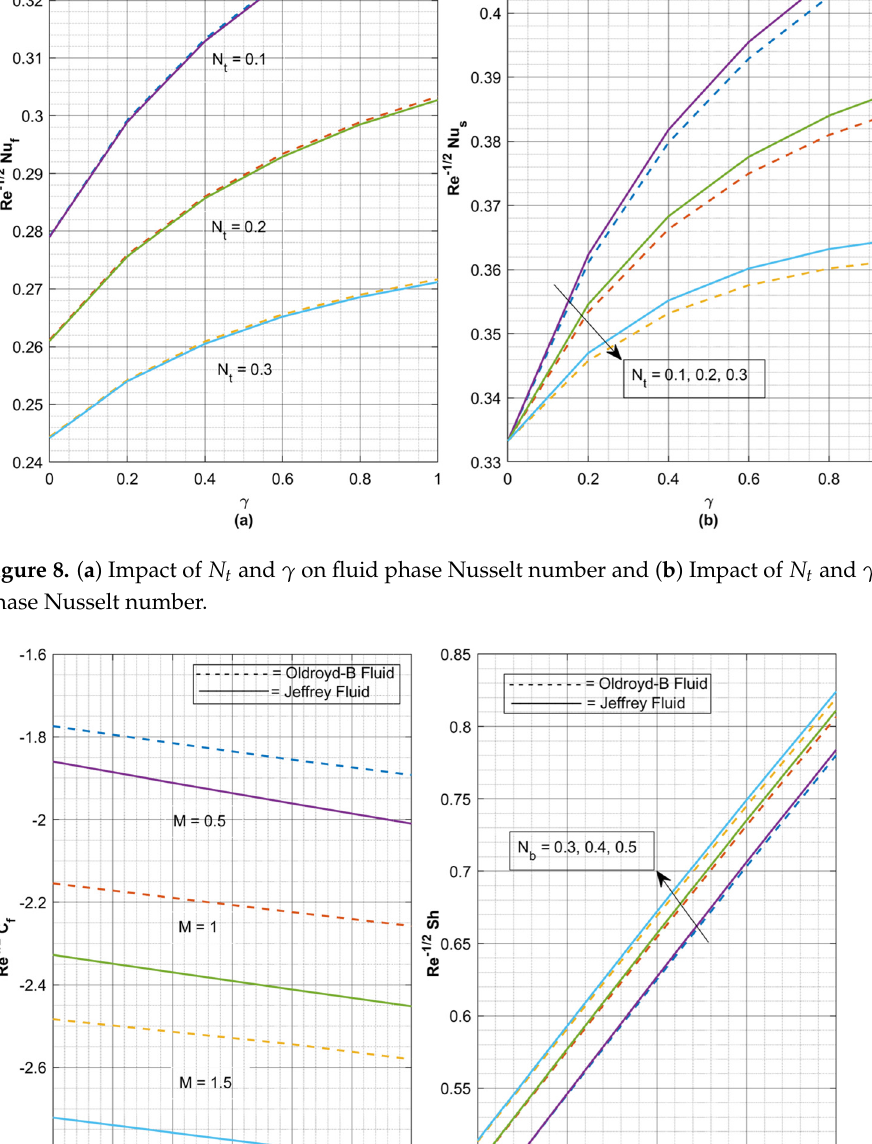
Figure 9. (a) Plot for skin friction and (b) Plot for Sherwood number.